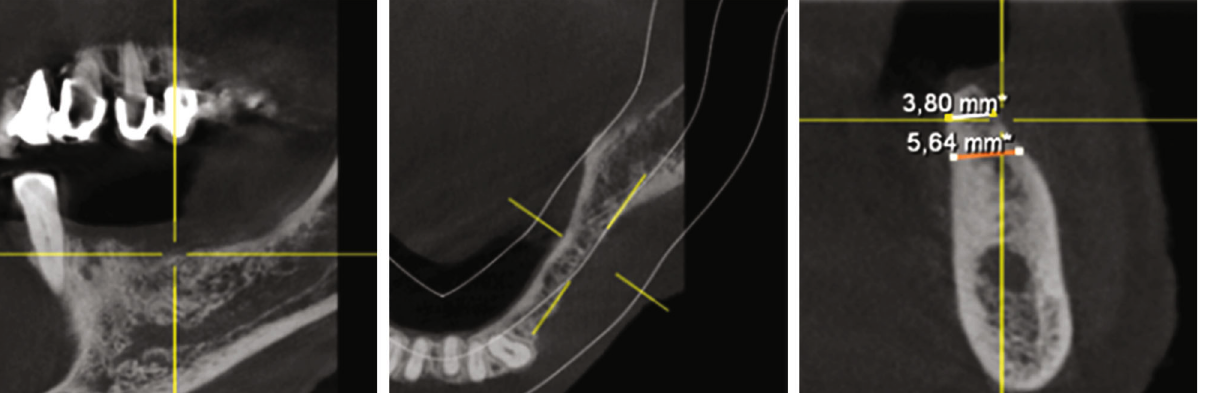
Figure 6: DVT — section region 36.